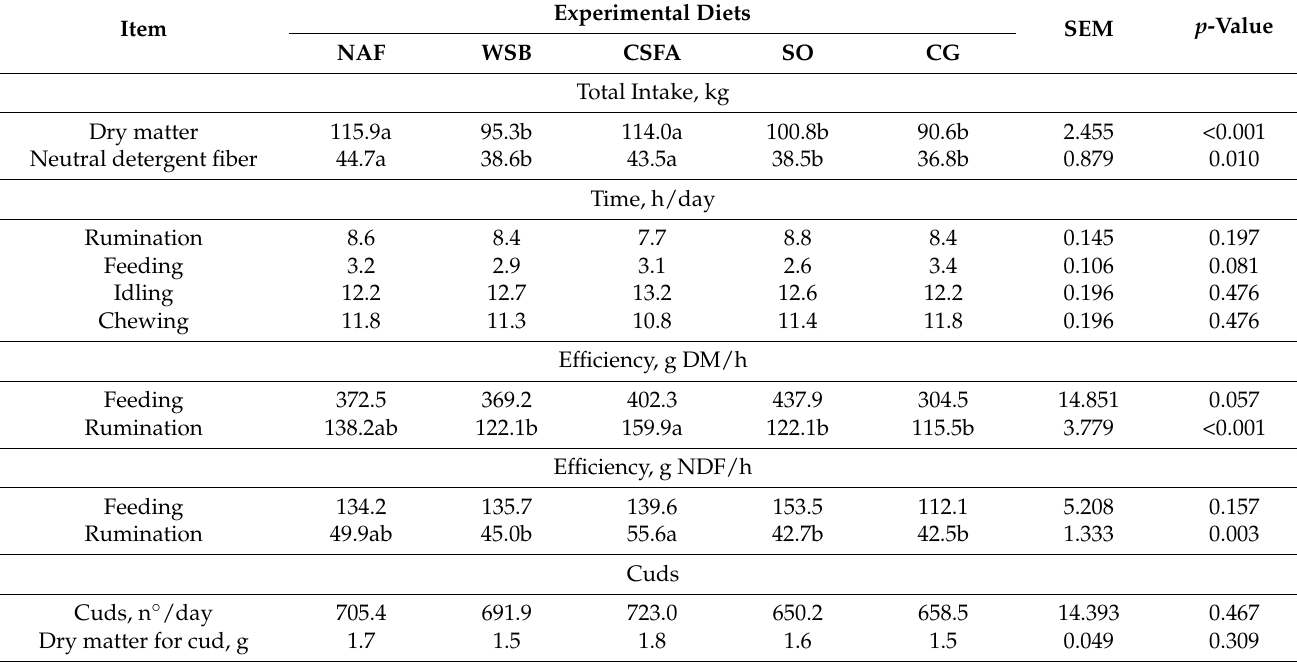
Table 2. Feeding behavior of feedlot lambs fed diets containing different fat